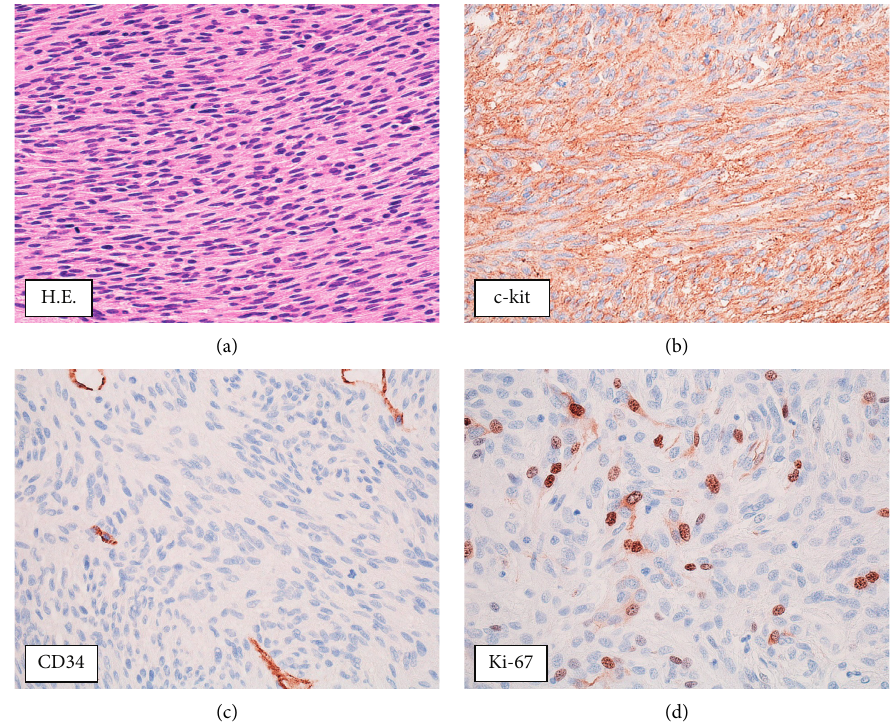
Figure 7: Pathological findings in the liver tumor at autopsy. Proliferation of atypical spindle-shaped cells was observed. The tumor was c- kit- and CD34-positive, confirming the diagnosis of GIST. MIB-1 labelling index was 12% (x 400).